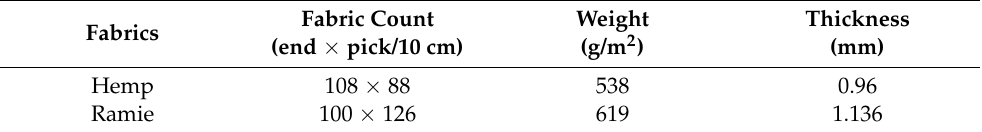
Table 1. Parameters of the fabrics.